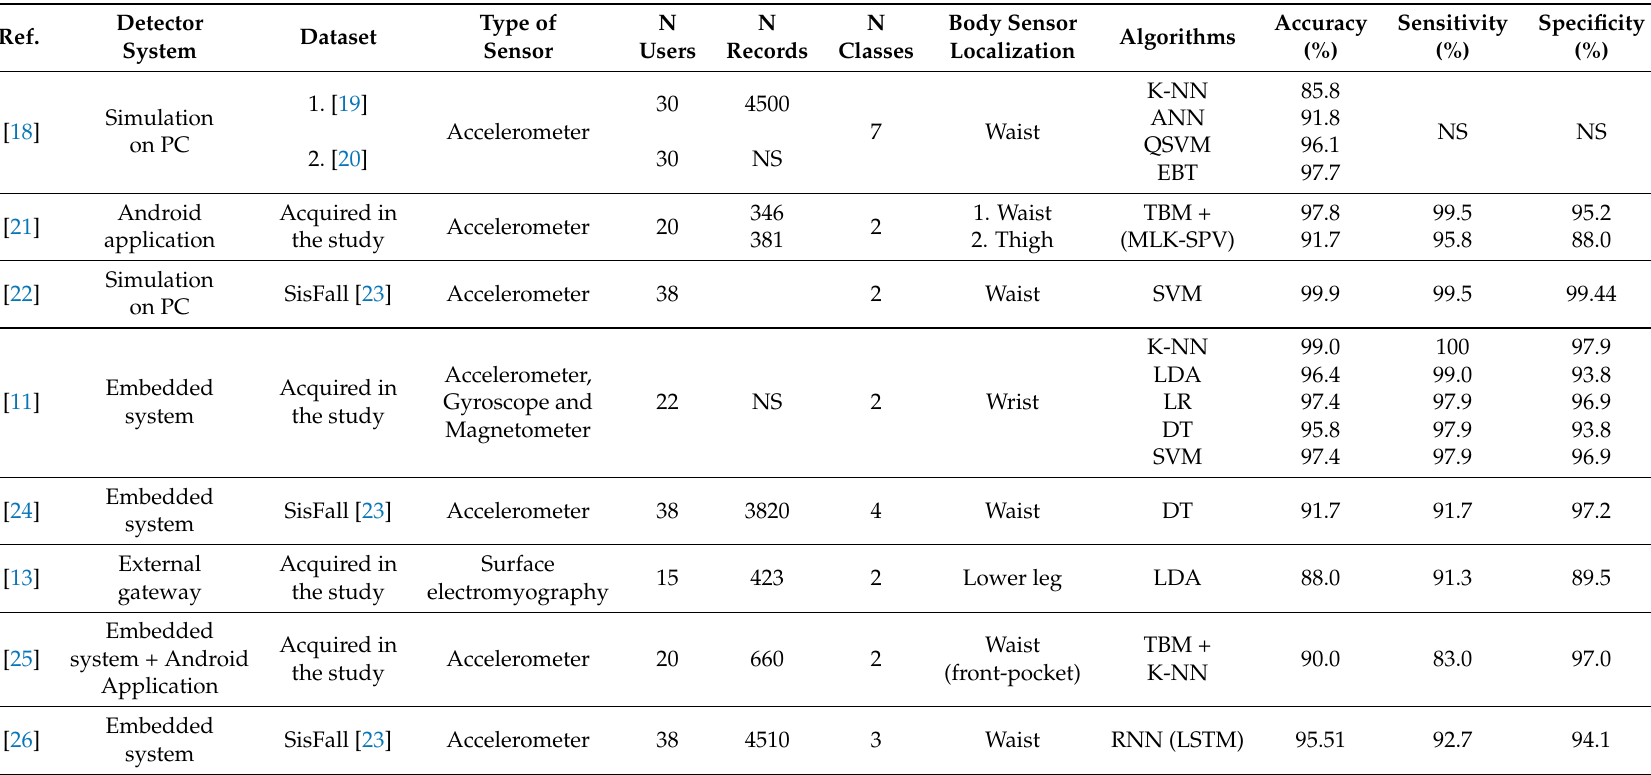
Table 1. Summary of most recent studies about wearable fall detector systems using machine learning.